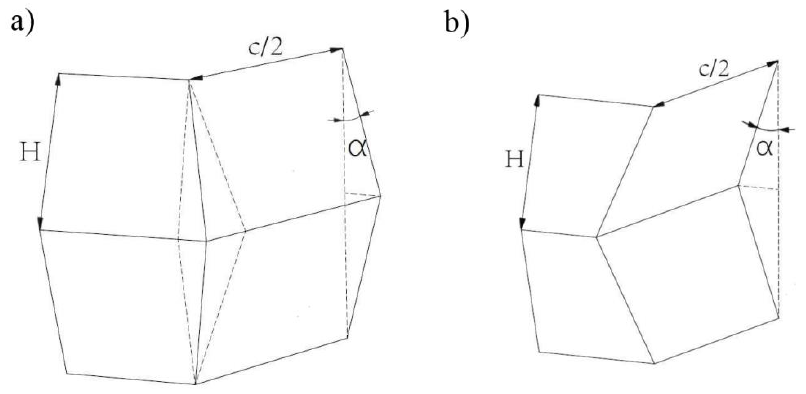
Figure 2. Dynamic progressive buckling of column: ( a ) asymmetrical; ( b ) symmetrical.